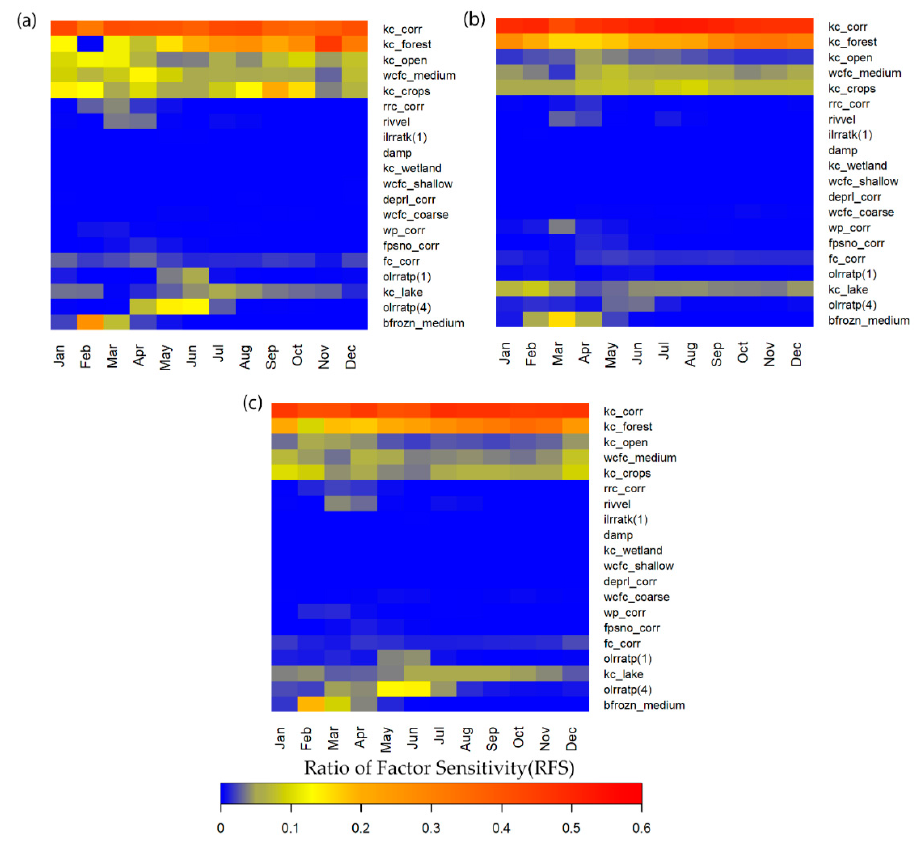
Figure 6. Heat map representing the sensitivity of model parameters expressed as a ratio of factor sensitivity based on ( a ) Nash Sutcliffe Efficiency ( NSE ), ( b ) Percent Bias ( PBIAS ), and ( c ) Normalized Root Mean Square Error ( NRMSE ) for the evaluation period of 1981–2010.